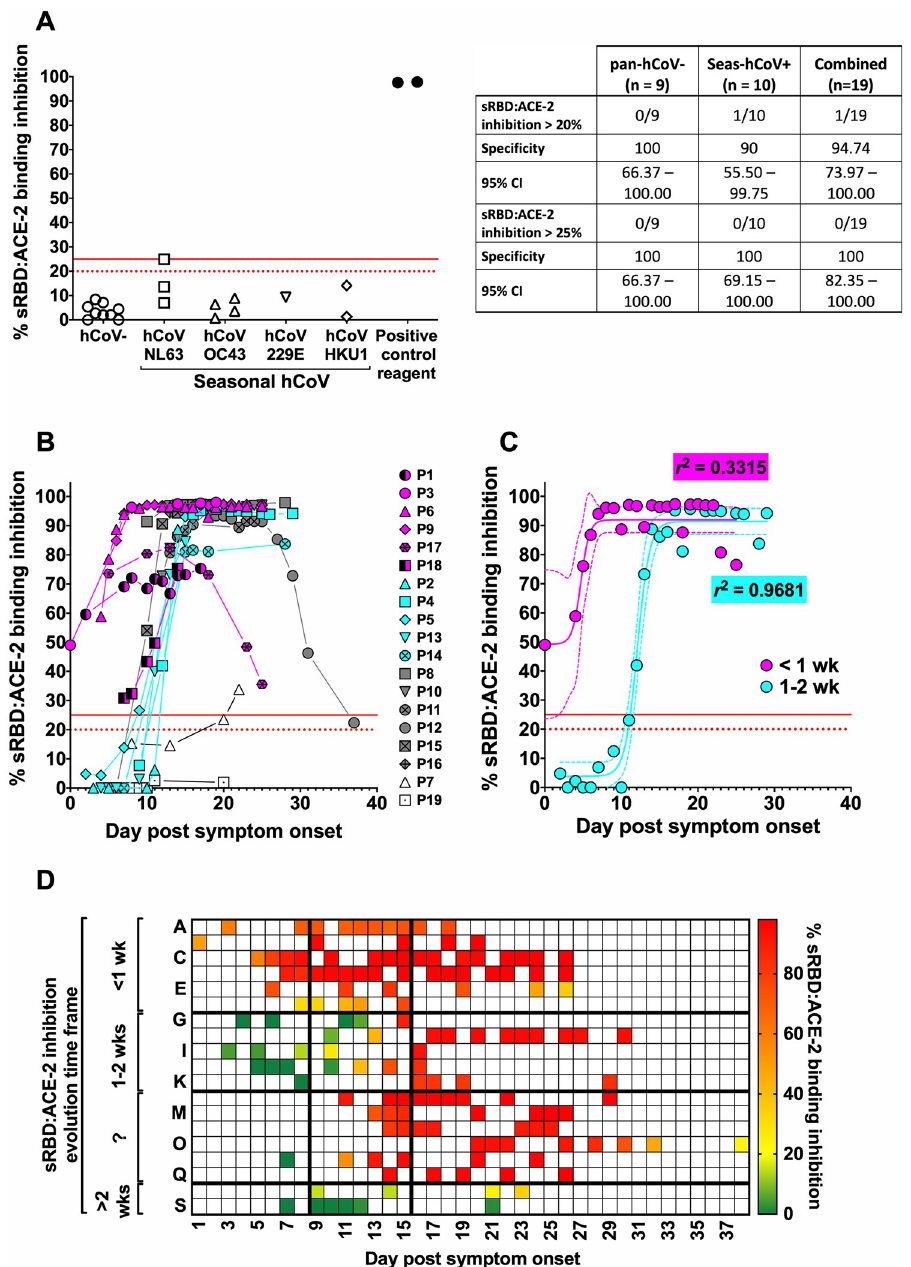
Fig 3. RBD:ACE-2 binding inhibition potency of antibodies produced over seroconversion. Serum samples collected from the cohort members following the onset of symptoms were analysed for RBD:ACE-2 binding inhibition potency by the GenScript surrogate Virus Neutralisation Test (sVNT). ( A ) An assessment of the assay specificity was conducted using hCoV seronegative sera (n = 9) and seasonal hCoV sera (n = 10). The calculated sensitivity and specificity of the anti-RBD IgG ELISA are described in the table. ( B ) Individual time-course data and ( C ) best-fit curves for RBD:ACE-2 inhibition evolving after < 7 days or between 7–14 days pso. In B+C –the manufacturer’s suggested sVNT assay cut-off (20% sRBD:ACE-2 binding inhibition relative to the negative control) is indicated by broken red line, and the ‘in-house’ applied cut-off (25%) is indicated by solid red line. Patients #1 and #18 were considered outliers and were therefore excluded from best-fit curve analyses. In C –dashed lines indicate 95% CI ranges; r 2 values describe tightness of fit. ( D ) Data from B presented as a heat-map. ‘?’ indicates undetermined seroconversion time